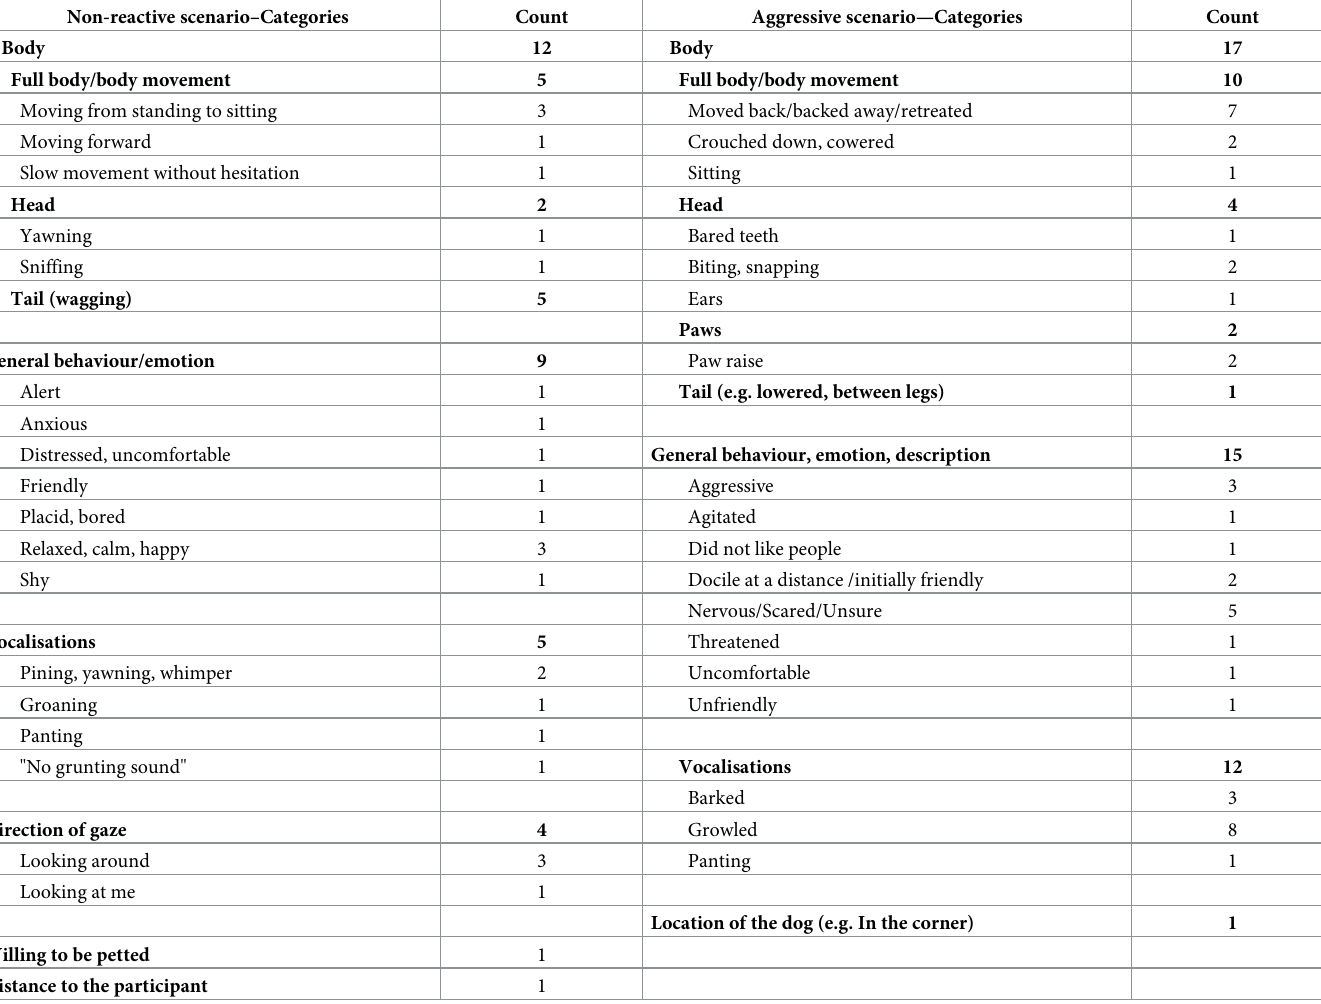
Table 2. Categorised open-ended responses to the question “ Did you notice anything about the behaviour(s) of the dog ” for both non-reactive and aggressive explo- ration scenario. Multiple descriptions were coded separately (e.g., cowered and bared teeth were coded in two separate categories) per respondent. Non-reactive